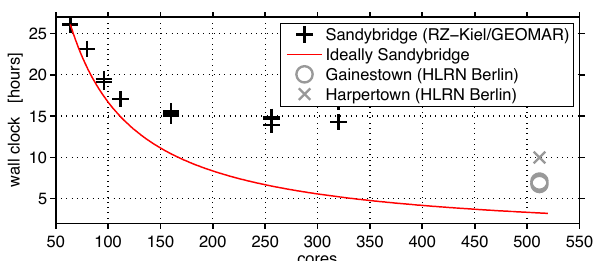
Figure 22. Computational performance (wall-clock hours required Fig. 22. Computational performance (wall clock hours required to integrate one year) as a func- tion of allocated computational cores. Black crosses, grey circles and grey x refer to architec- to integrate 1 year) as a function of allocated computational cores. tures based on Sandybridge, Gainstown and Harpertown CPUs, respectively. The red line Black crosses, grey circles and the grey x refer to architectures depicts a theoretic, ideal parallel performance of the code on the Sandybridge architecture. based on Sandybridge, Gainestown and Harpertown CPUs, respec- tively. The red line depicts a theoretical, ideal parallel performance of the code on the Sandybridge